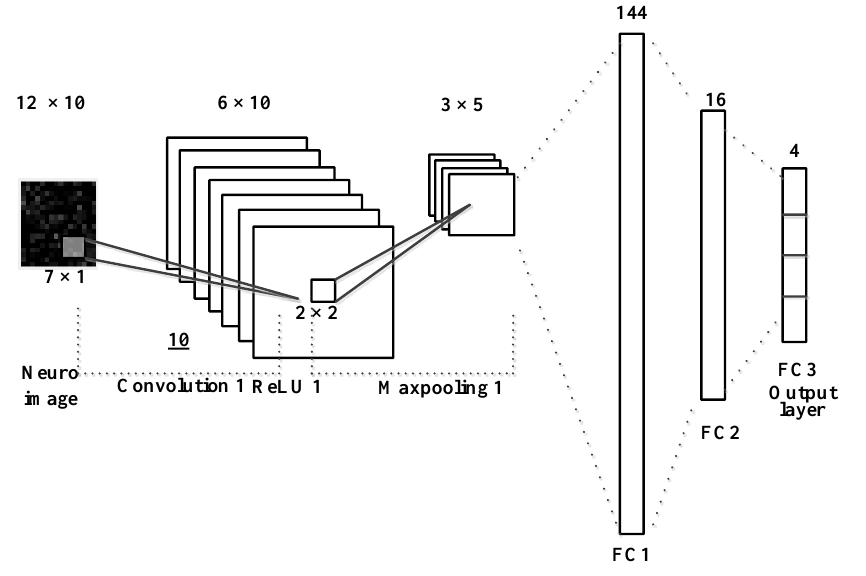
Figure 6. The CNN for neuro images in QR-EFA.